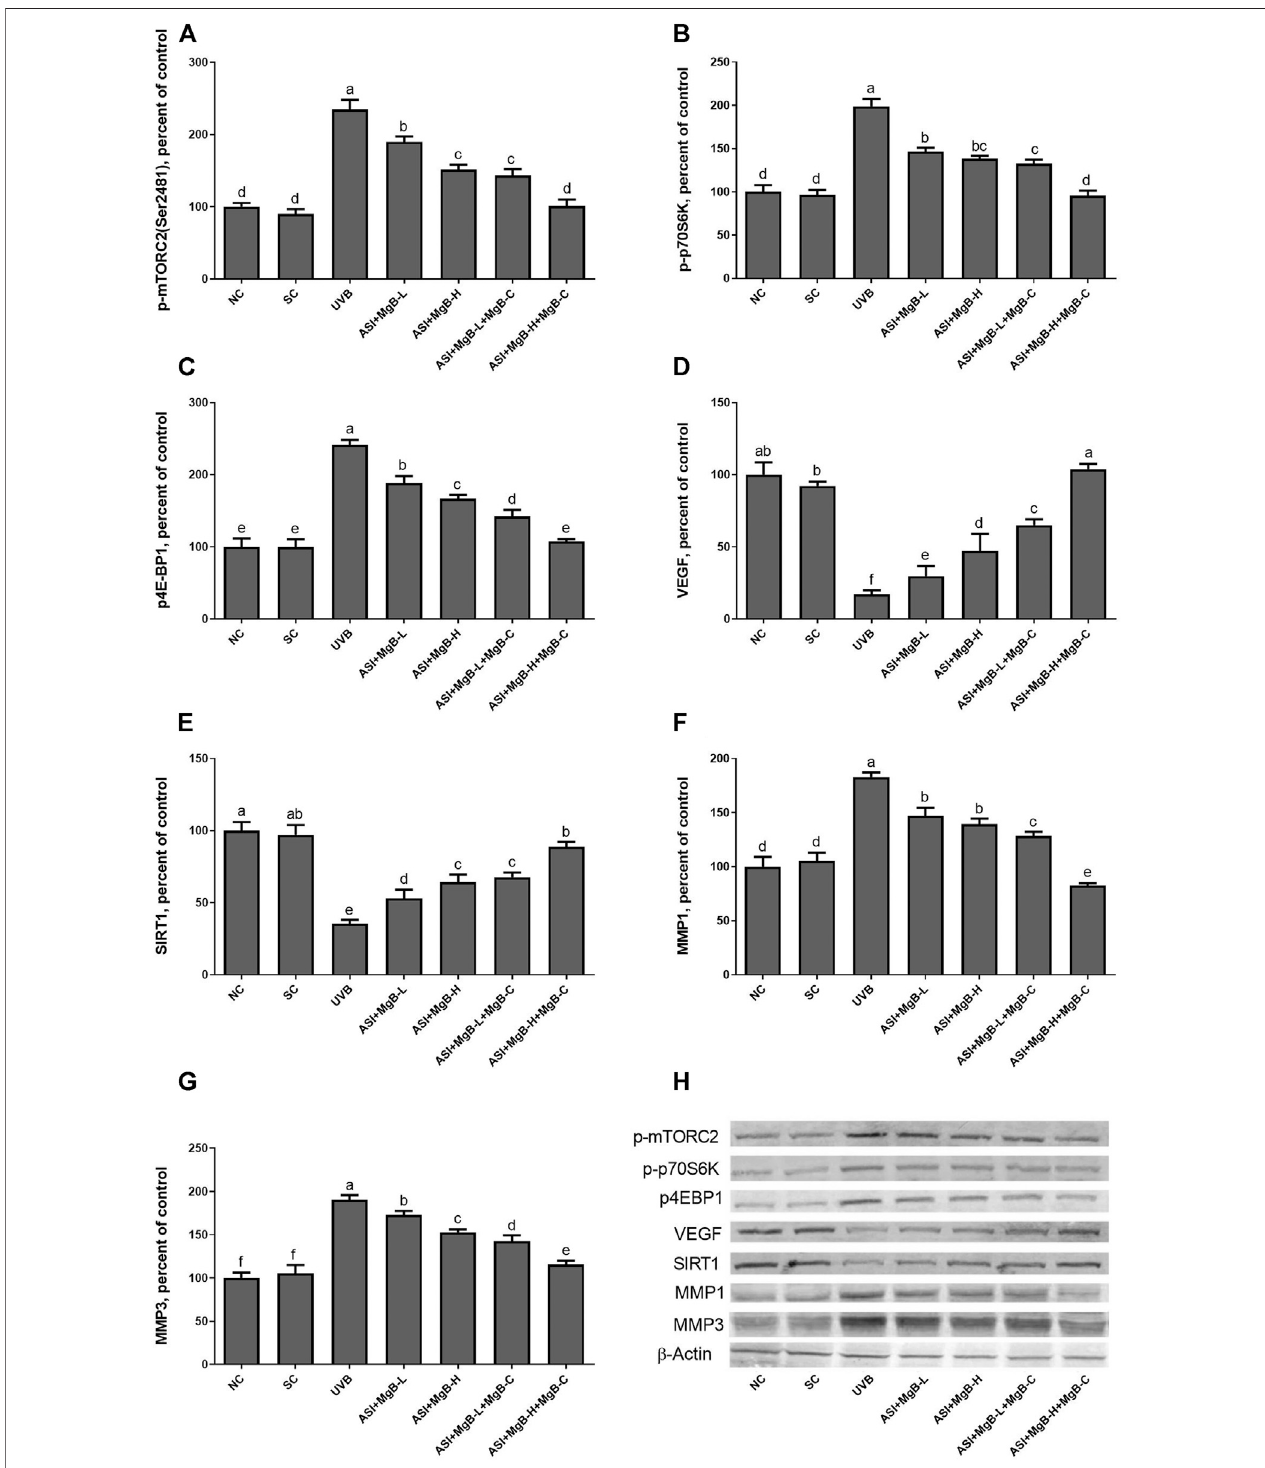
FIGURE 4 | Effect of inositol-stabilized arginine silicate complex (ASI) and magnesium biotinate (MgB) on the mammalian target of rapamycin comple × 2 (p-mTORC2; A ), ribosomal protein S6 kinase beta-1 (p-p70S6K; B ), eukaryotic initiation factor 4E-binding protein 1 (p4E-BP1; C ), vascular endothelial growth factor (VEGF; D ), sirtuin 1 (SIRT1; E ), matrix metalloproteinase-1 (MMP-1; F ), and matrix metalloproteinase-3 (MMP-3; G ) protein levels in rats with UVB-induced photoaging. Dataare expressed asapercent ofthe control value. Each bar representsthe mean and standard error ofthe mean. Blots were repeated at least 3 times. Western blot analysis was performed with actin included ensuring equal protein loading (H) . a – f : Values within the bars with different superscripts are signi fi cantly different (One-way ANOVA and Tukey ’ s post-hoc test, p < 0.05).